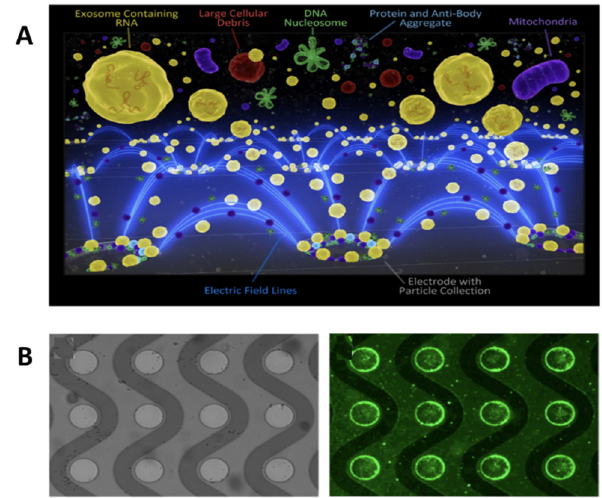
Figure 6. Schematic of exosomes and other particles separated with the alternating current electrokinetic (ACE) microarray chip. ( A ) ACE microarray chip fluorescent schematic of dielectrophoretic separation force pulling exosomes to microelectrodes. ( B ) Bright-field image of the circular microelectrodes (left) and fluorescent image of CD63 at the electrode edges (right) (reprinted with permission from Ibsen et al. American Chemical Society 2017).